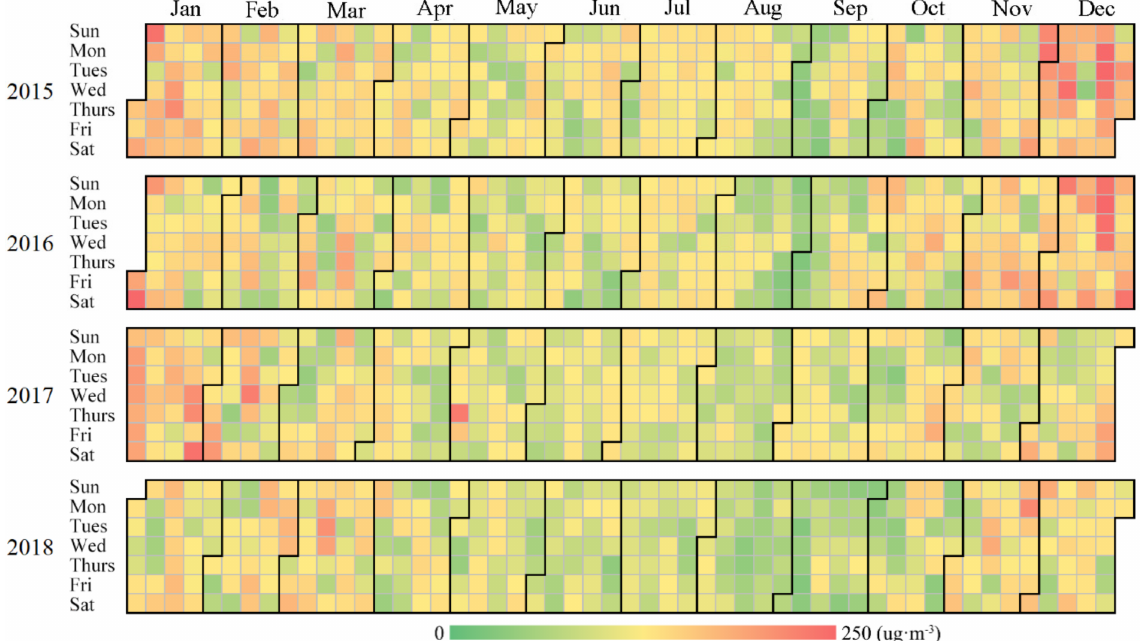
Figure 4. Thermographic calendar of daily PM 2.5 concentration.